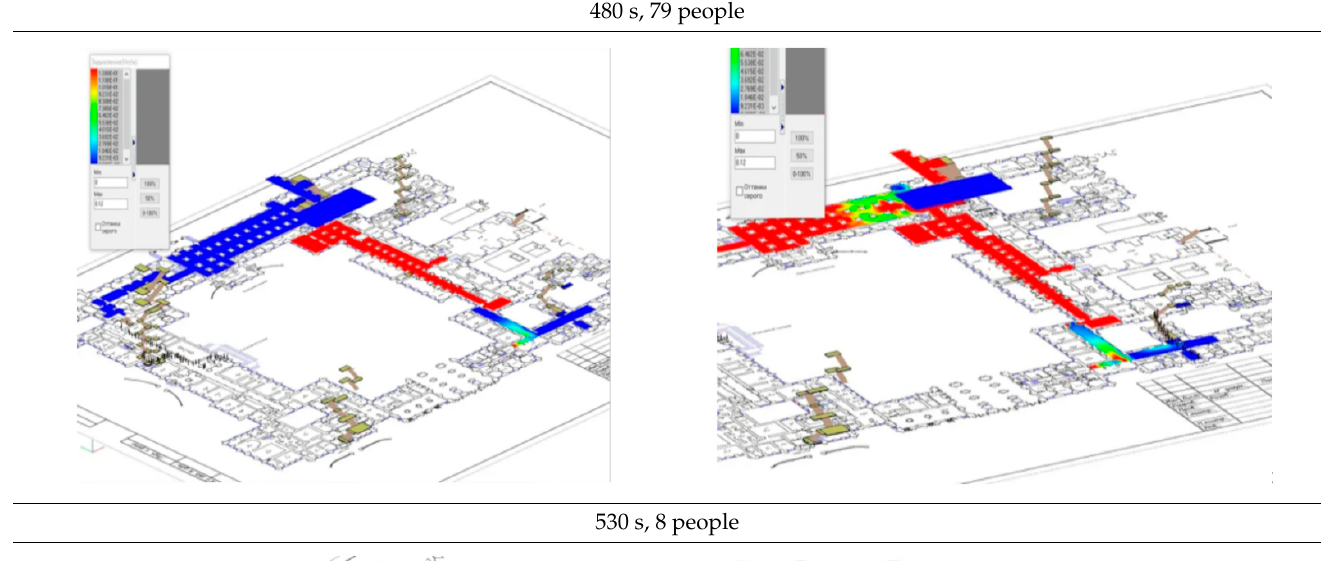
Table 2. Cont. Visualization of the Smoke Field (Doors